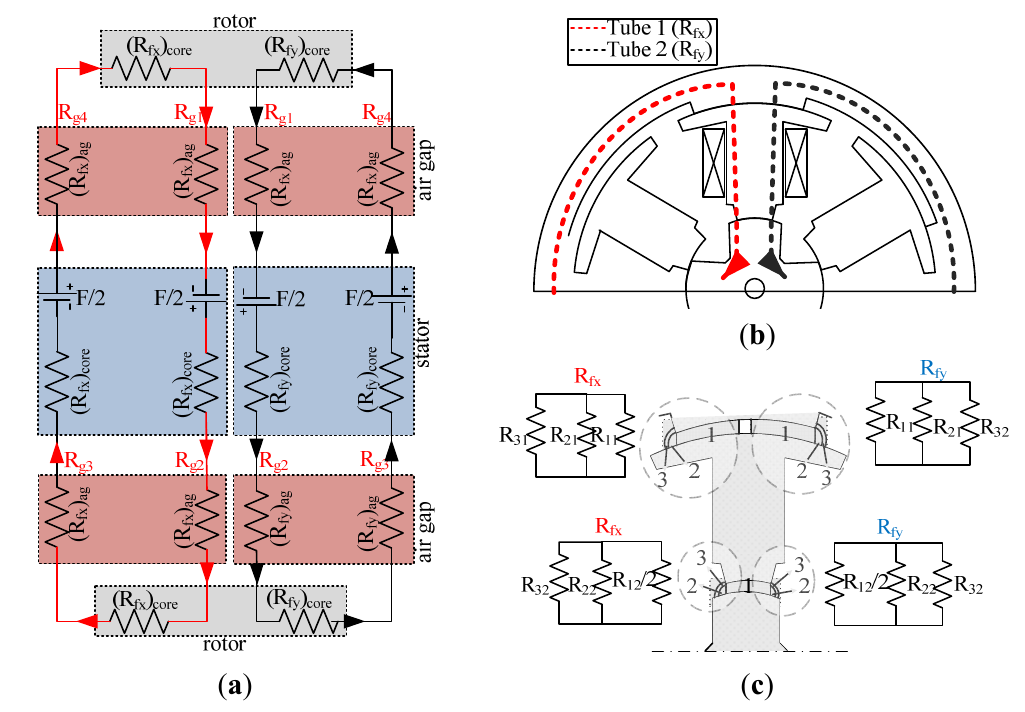
Figure 7. Flux flow representation during aligned position: ( a ) Magnetic Circuit; ( b ) Flux flow; ( c ) Air-gap